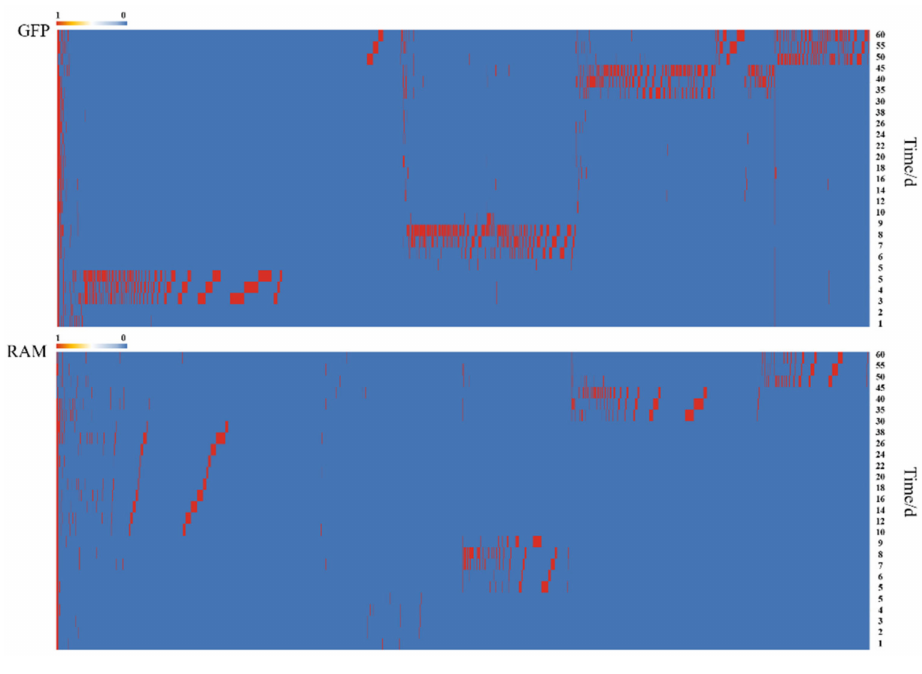
Figure 3. Distribution of ASVs identified in 60 days.